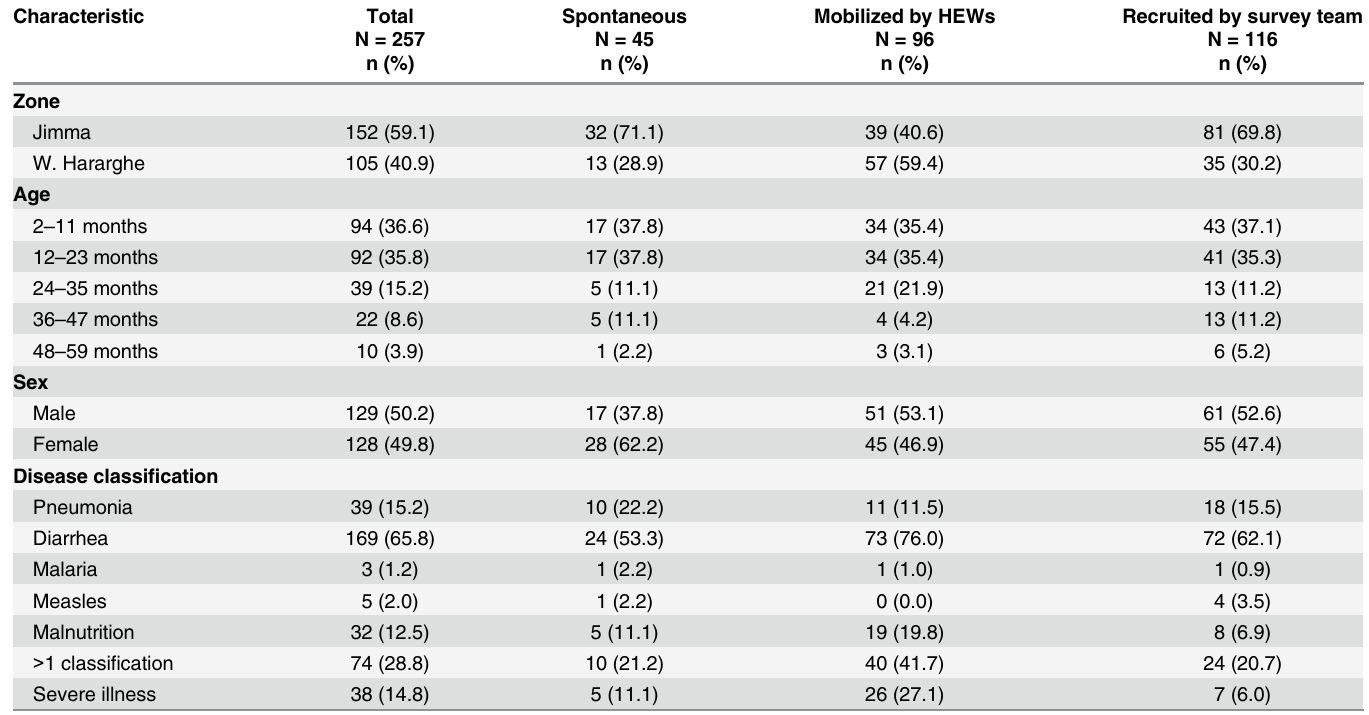
Table 1. Characteristics of the sample of sick children by recruitment